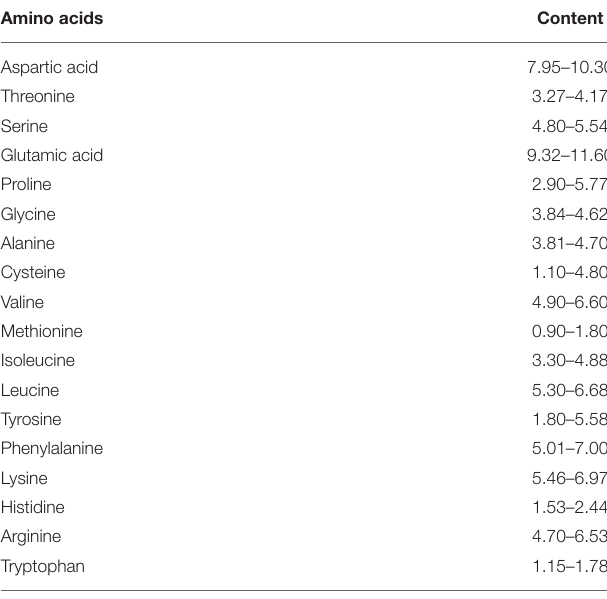
TABLE 1 | Amino acid content (g/100g protein) of African oil bean